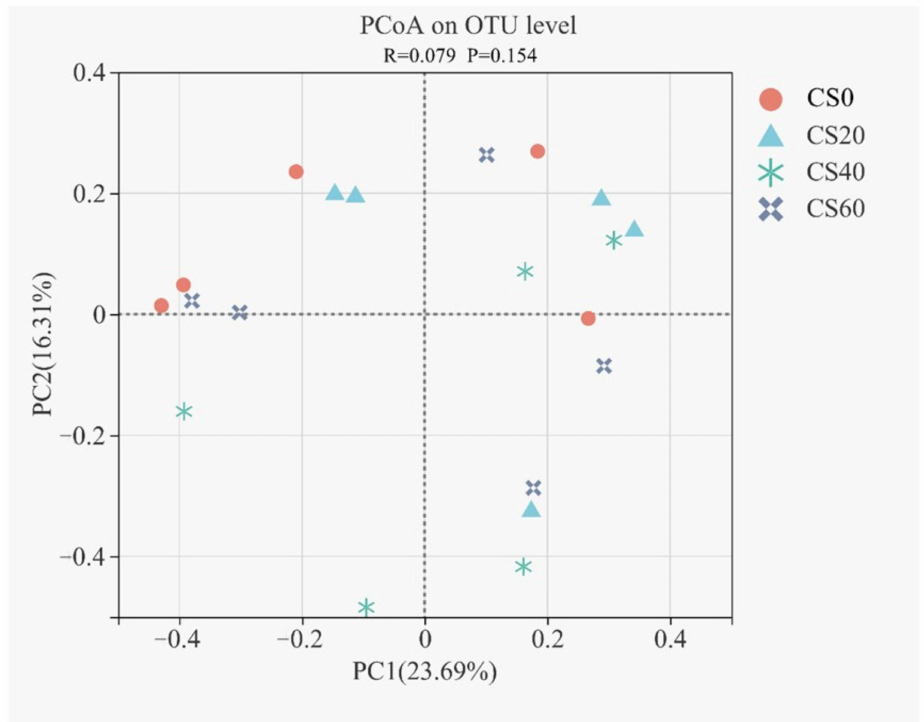
Figure 2. Principal coordinates analysis (PCoA) plot based on the Bray–Curtis dissimilarity matrix to compare the bacterial structure among feedlot lamb feed rations with different supplementary concentrations of cysteamine (CS0, control group; CS20, 20 mg/kg BW; CS40, 40 mg/kg BW; CS60, 60 mg/kg